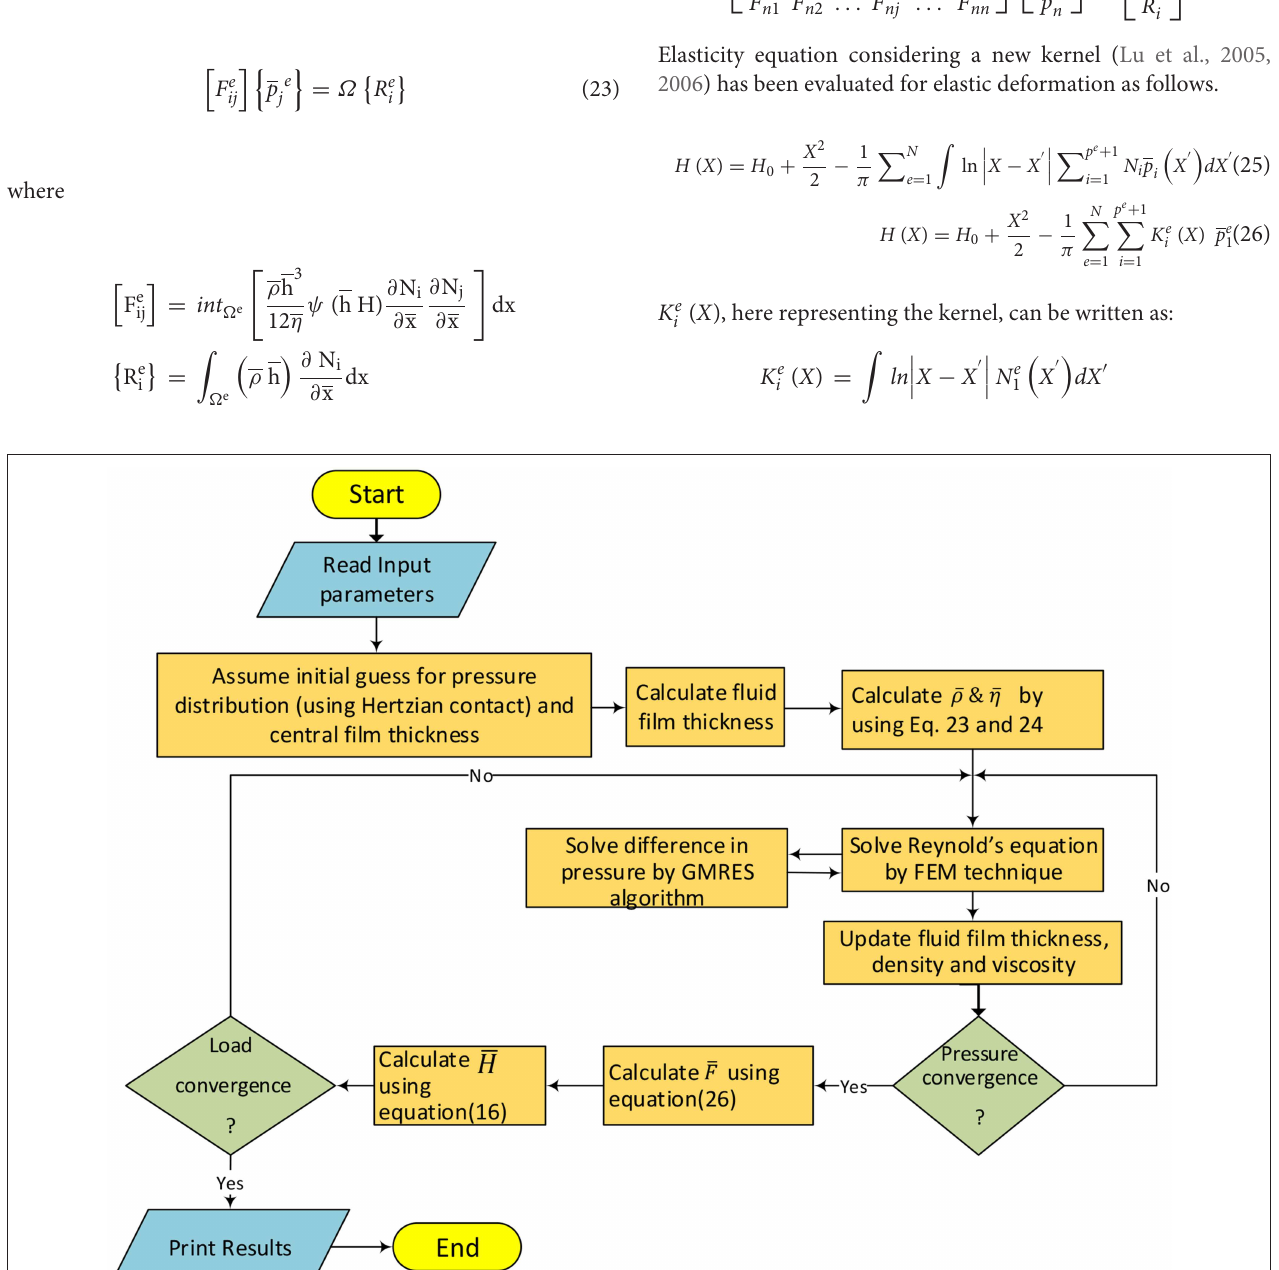
FIGURE 4 | Solution scheme of EHL